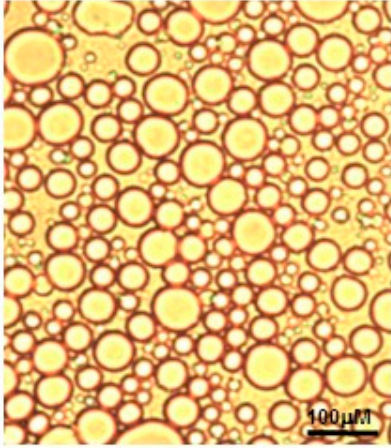
Figure 3. Optical microscopy of the optimized emulsion at 400 × magnification.